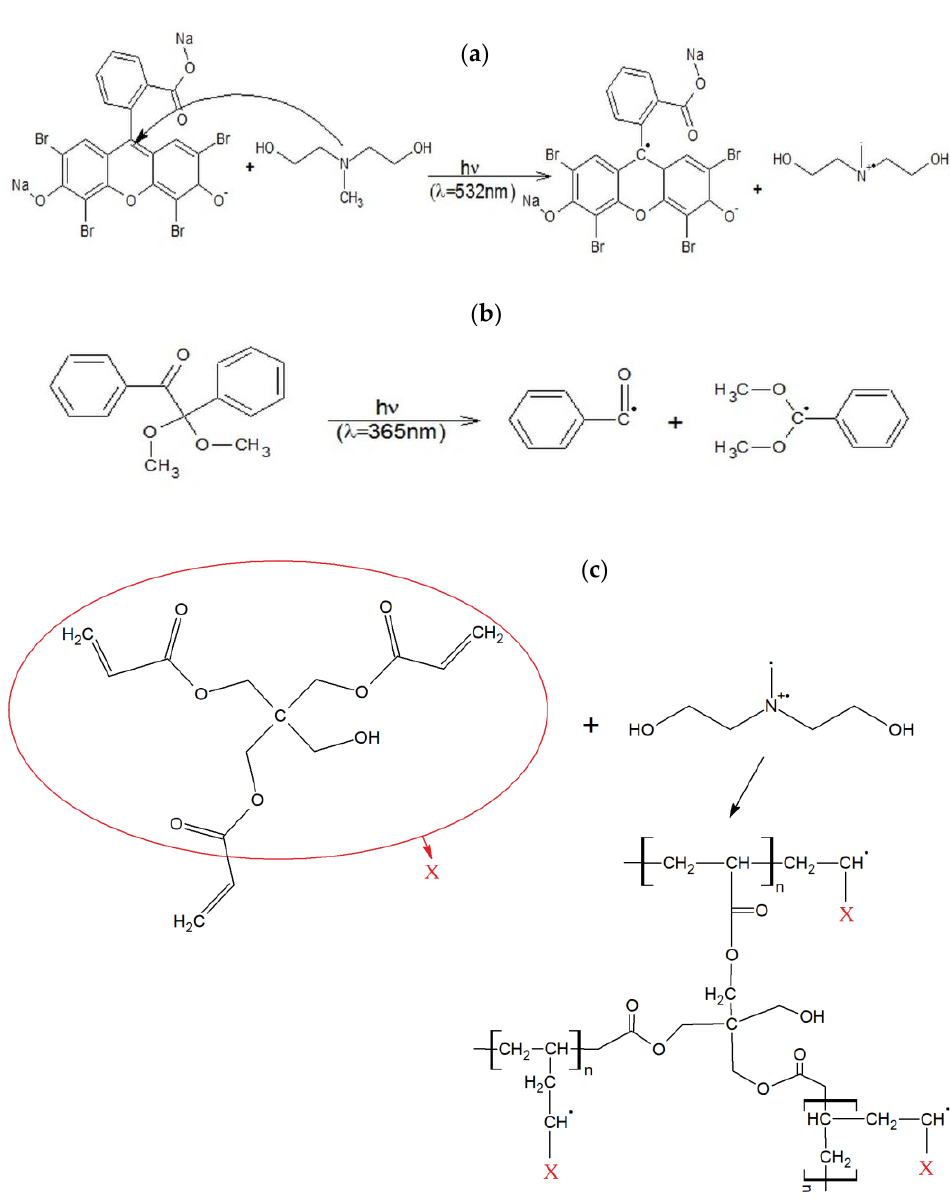
Figure 2. Examples of a photopolymerization reactions courses: ( a ) initiation excited by the VIS photon with a wavelength of 532 nm, ( b ) initiation excited by the UV photon with a wavelength of 365 nm, ( c ) PETA mixture — propagation and termination shown as an example for one of the C=C bonds in this 3-functional monomer (X — further polymerization).